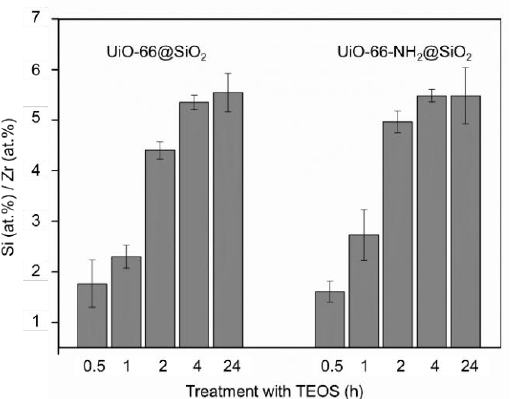
Figure 3. Si/Zr ratio in UiO-66@SiO 2 and UiO-66-NH 2 @SiO 2 MOFs treated with TEOS for different durations.